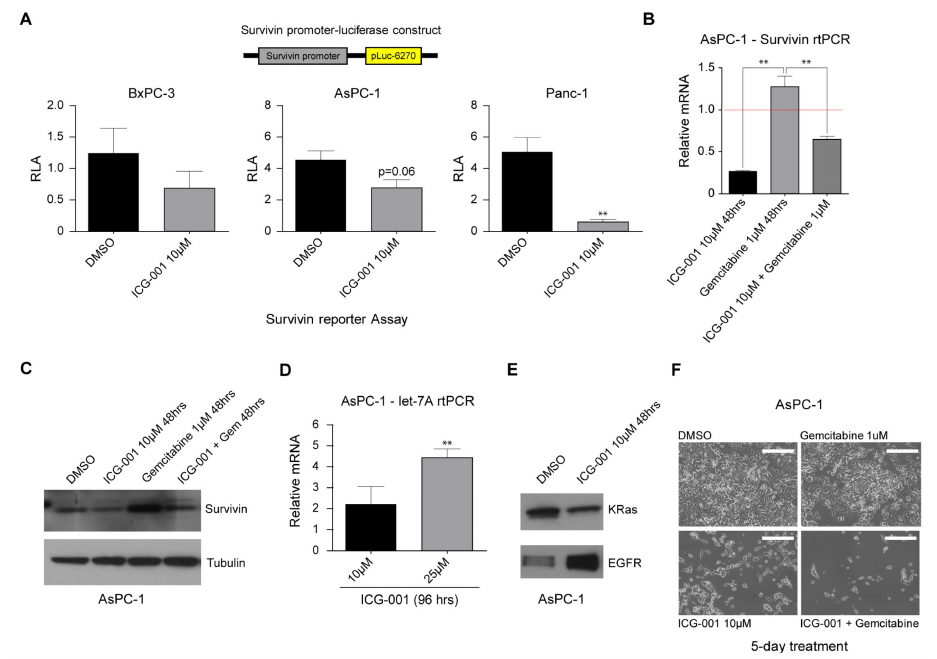
Figure 3. ICG-001 counteracts survivin and K-Ras pathways, sensitizing human pancreatic cancer cells to conventional therapy. ( A ) The survivin/luciferase promoter construct (pLuc-6270) was used to evaluate the effects of ICG-001 in BxPC-3, AsPC-1, and PANC-1 cells. Treatment with ICG-001 decreased survivin/luciferase activity in all three cell lines. n = 3, ** p < 0.01, compared to DMSO control. RLA, relative luciferase activity. ( B , C ) ICG-001 decreased survivin message (relative mRNA expression